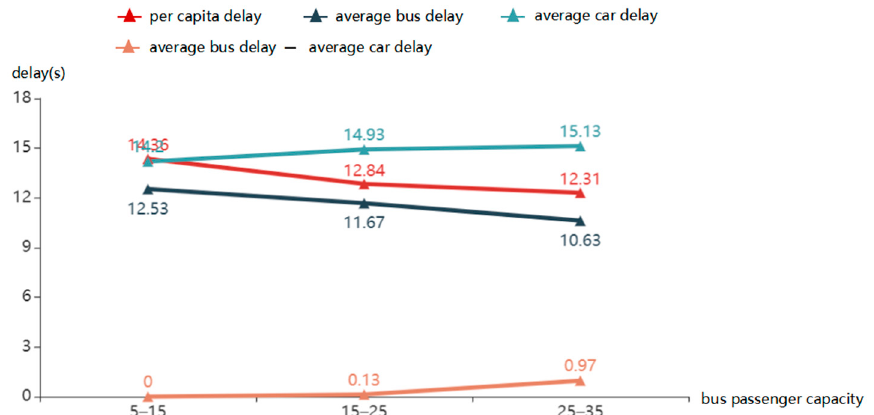
Figure 18. Optimization results for buses with different passenger capacity.